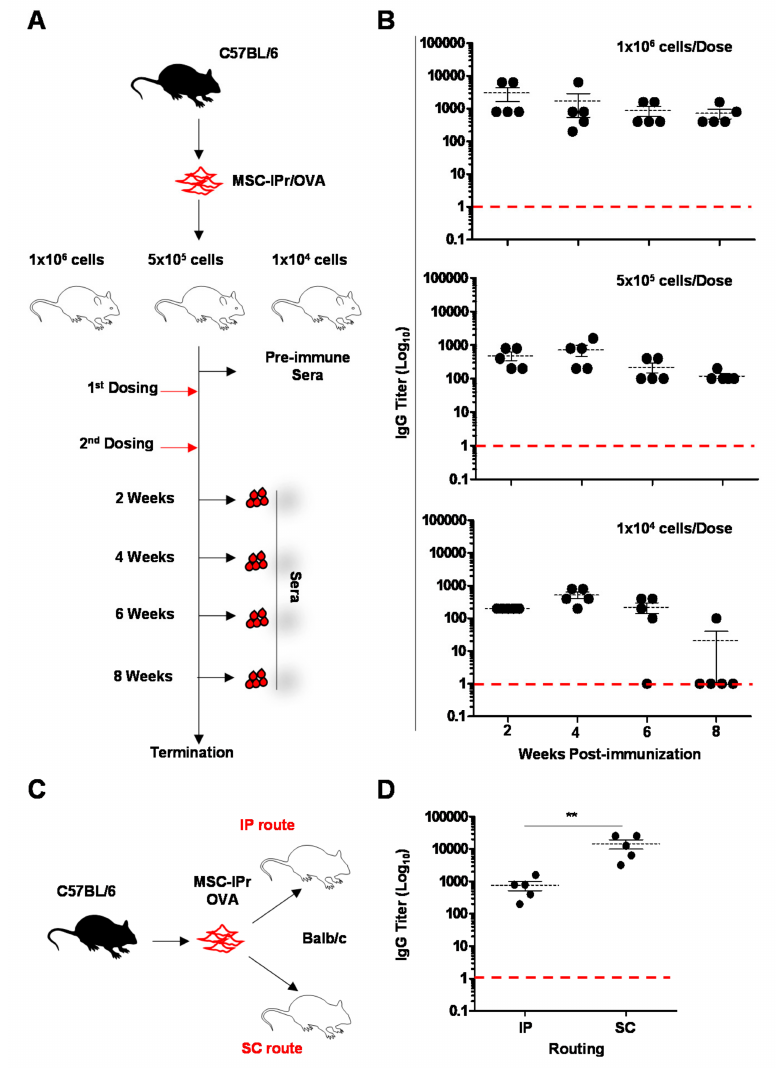
Figure 2. Antibody titers in response to various dosing and routes. ( A ) Schematic diagram rep- resenting the immunization approach used to compare the potency of various cellular doses via the IP route. ( B ) Antibody titer analysis conducted every two weeks in response to three different allogeneic MSC-IPr immunization doses. The red dashed line represents the values of pre-immune sera. ( C ) Schematic diagram representing the immunization approach used to compare the IP and SC routes. ( D ) Antibody titer analysis conducted at week 4 post-initial SC dosing using 1 × 10 6 OVA-pulsed MSC-IPr. The red dashed line represents the values of pre-immune sera. For panels B and D, n = 5/group with and ** p <